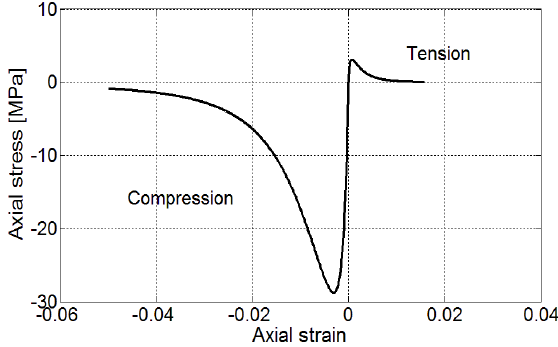
Figure 4. Constitutive law for mortar matrix [29].